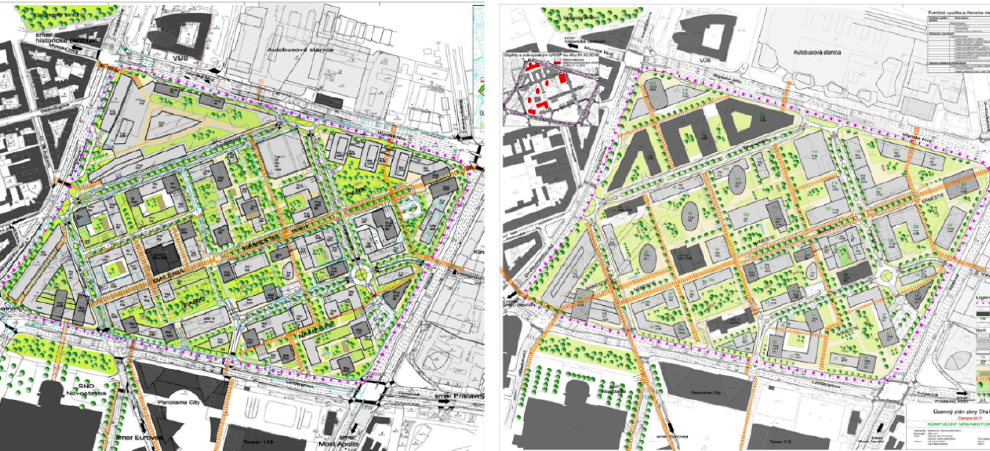
Figure 1. From left to right: The urbanistic study 2008; the approved zonal plan 2018. Source: The Old Town City District (2018).